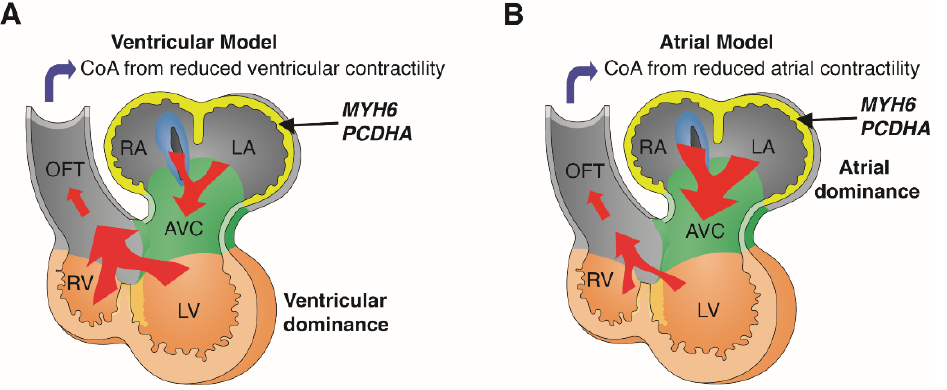
Figure 4. Atrial vs. ventricular hemodynamic model of coarctation. MYH6 and PCDHA are both expressed predominantly in the atria during early human and mouse embryonic development. Ventricular model of coarctation (CoA) ( A ) proposes that flow provided by ventricular contractile force plays a predominant role in the developmental etiology of CoA ( A ). In contrast, in the atrial model of CoA ( B ), flow provided by atrial contraction plays a predominant role in the developmental etiology of CoA. Diagrams adapted with permission from van Eif et al. (2018) [32]. RA , right atrium; LA , left atrium; AVC , atrioventricular canal; RV , right ventricle; LV , left ventricle; OFT , outflow tract.